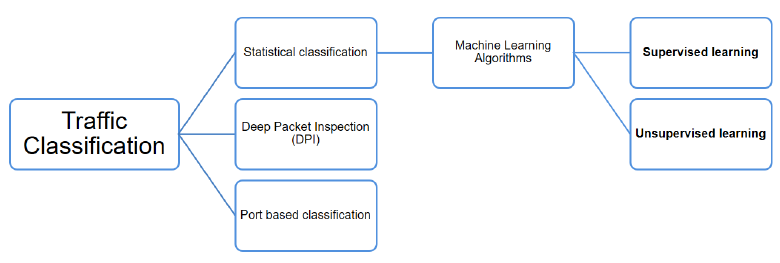
Figure 1. Traffic classification